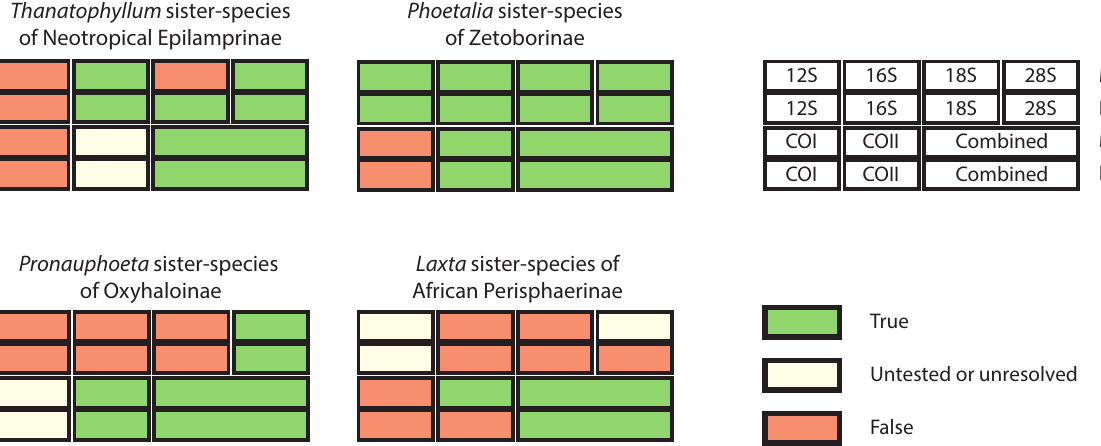
Fig. 2. Conflicting results among different molecular markers. The phylogenetic relationships of four species are detailed for separate and combined analyses performed in Maximum Likelihood (ML) and Bayesian Inference (BI). Boxes colored as ‘Untested or unresolved’ refer to missing data and multifurcation,